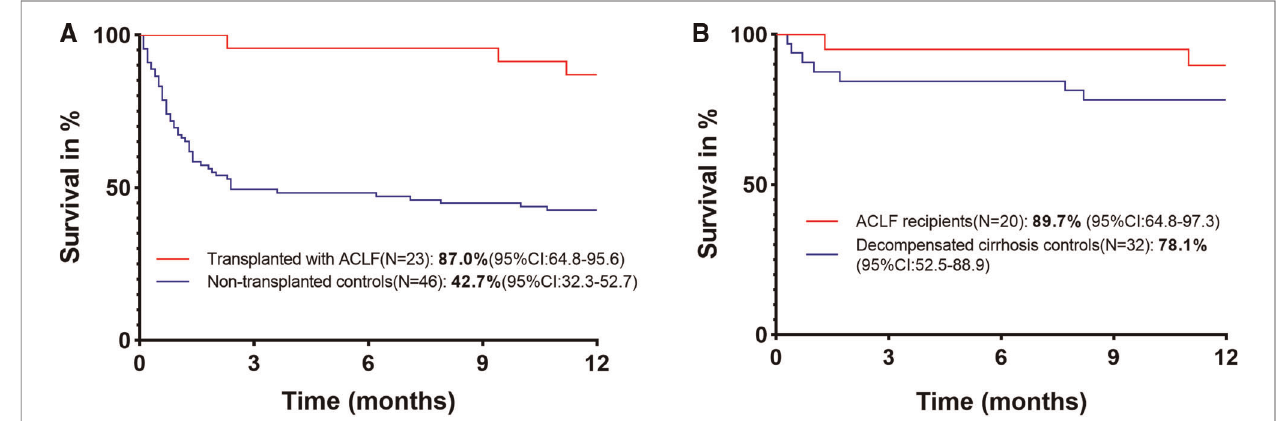
FIGURE 3 | ( A ) 1-year survival of transplanted and nontransplanted ACLF patients. ( B ) 1-year survival of ACLF and decompensated